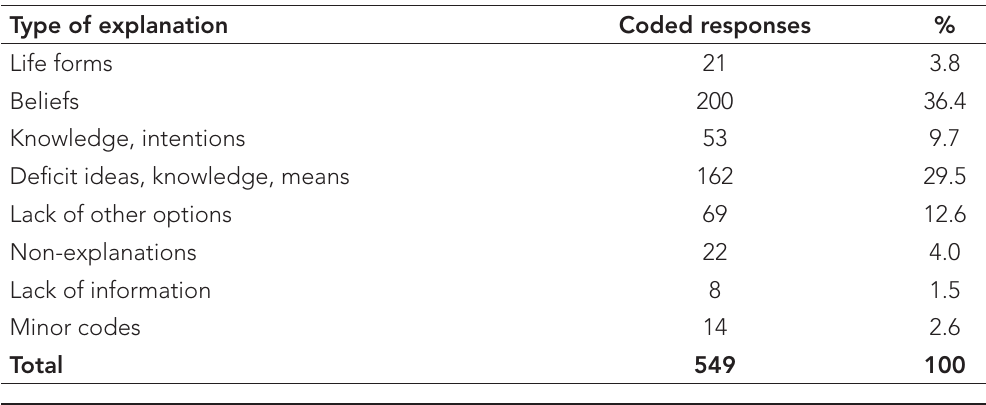
Table 1: Responses coded by type of explanation